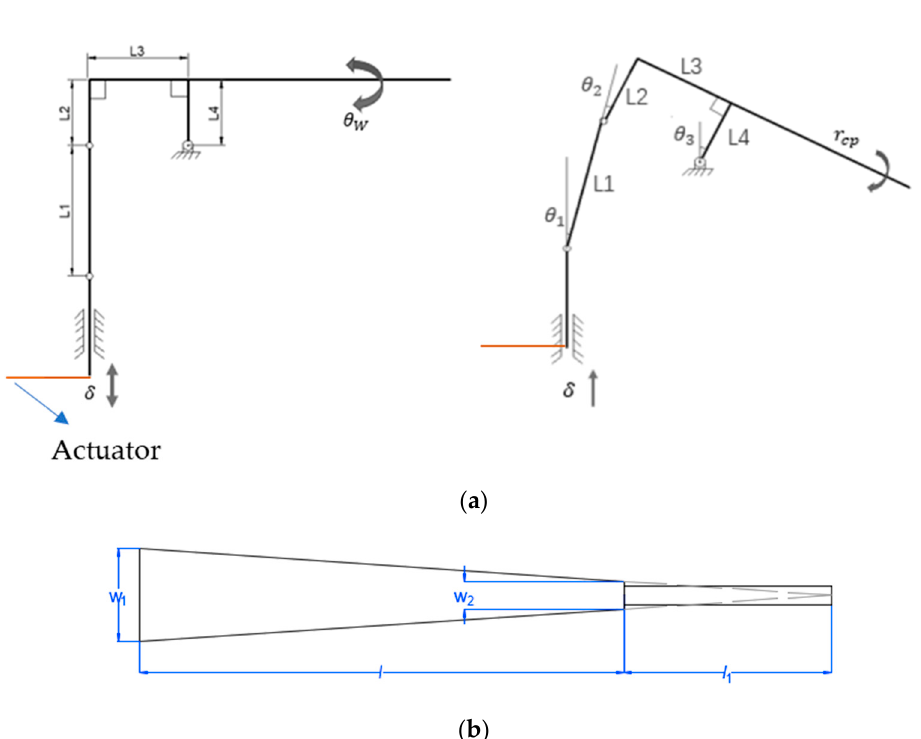
Figure 1. Design of deformation mechanics and actuator: ( a ) diagram of the structure of the spherical four-bar linkage; ( b ) plane profile of the piezoelectric actuator.